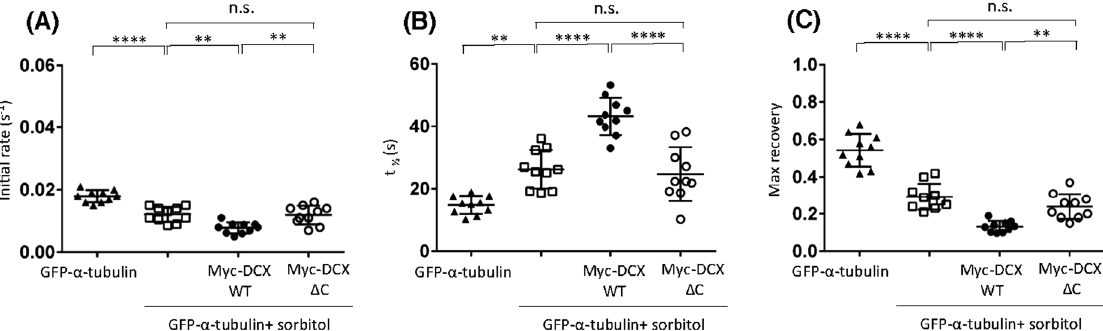
Figure 8. Hyperosmotic stress slowing of tubulin dynamic change is further slowed by DCX WT but not DCX Δ C. ( A – C ) The recovery of the ROI fluorescence for GFP- α -tubulin only and together with myc-DCX WT or myc-DCX Δ C under sorbitol treatment conditions. Results are for the mean ± SEM for ( A ) the initial rate of recovery of fluorescence for GFP- α -tubulin only or together with myc-DCX WT or myc-DCX Δ C under sorbitol treatment conditions in the photobleached area (estimated over the initial 6 s post-bleach), ( B ) the time to reach half-maximal recovery of fluorescence (t 1/2 ), and ( C ) the fluorescence maximum recovery for GFP- α -tubulin in the bleached area. Error bars represent the standard error of the means and asterisks indicate values calculated to statistically significantly different ** p ≤ 0.01, **** p ≤ 0.0001, n = 10 cells in each of three independent experiments. n.s. = not